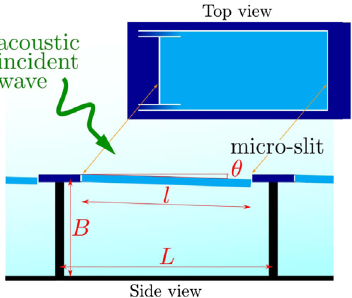
Figure 1. Sketch of a mono-articulated blade of length l with laser cut micro-slits. The structure is attached to a cavity with a thickness of B and a length of L . The rotation angle of the beam is denoted h